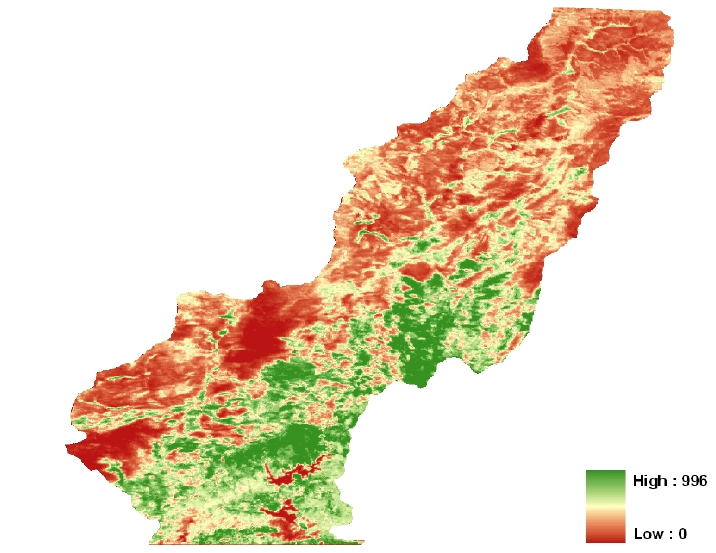
Figure 8 . Annual variation in NPP (g C m -2 yr -1 ) predicted for Seyhan watershed.